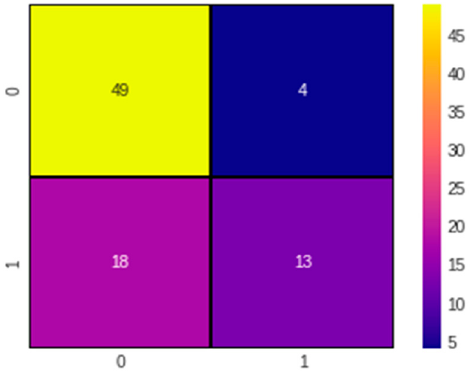
Figure 12. Confusion matrix of NB.